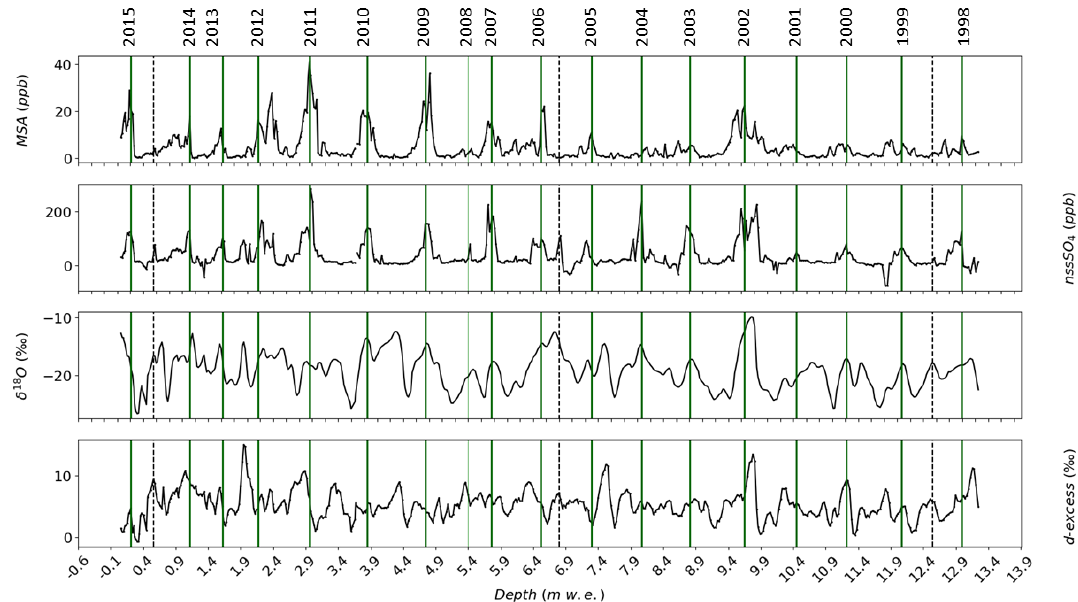
Figure 3. Identification of annual layers in the TA192A ice core based on the dual identification of nssSO 2 − comparison of estimated accumulation with annual accumulation measured at the closest stakes (not shown). The thick vertical green lines correspond to summer peaks identified from chemical signals, while the thin vertical green line shows the additional identification of summer 2008 added to the counted summers from the comparison between the estimated accumulation and the accumulation record from the closest stake data (see Fig. 3). Vertical dashed lines highlight equivocal summer peaks with a sometimes small signal in only one of the chemical records. Water stable isotope records were not used to build the timescale. Note that double peaks in both δ 18 O and d -excess occur repeatedly within one counted